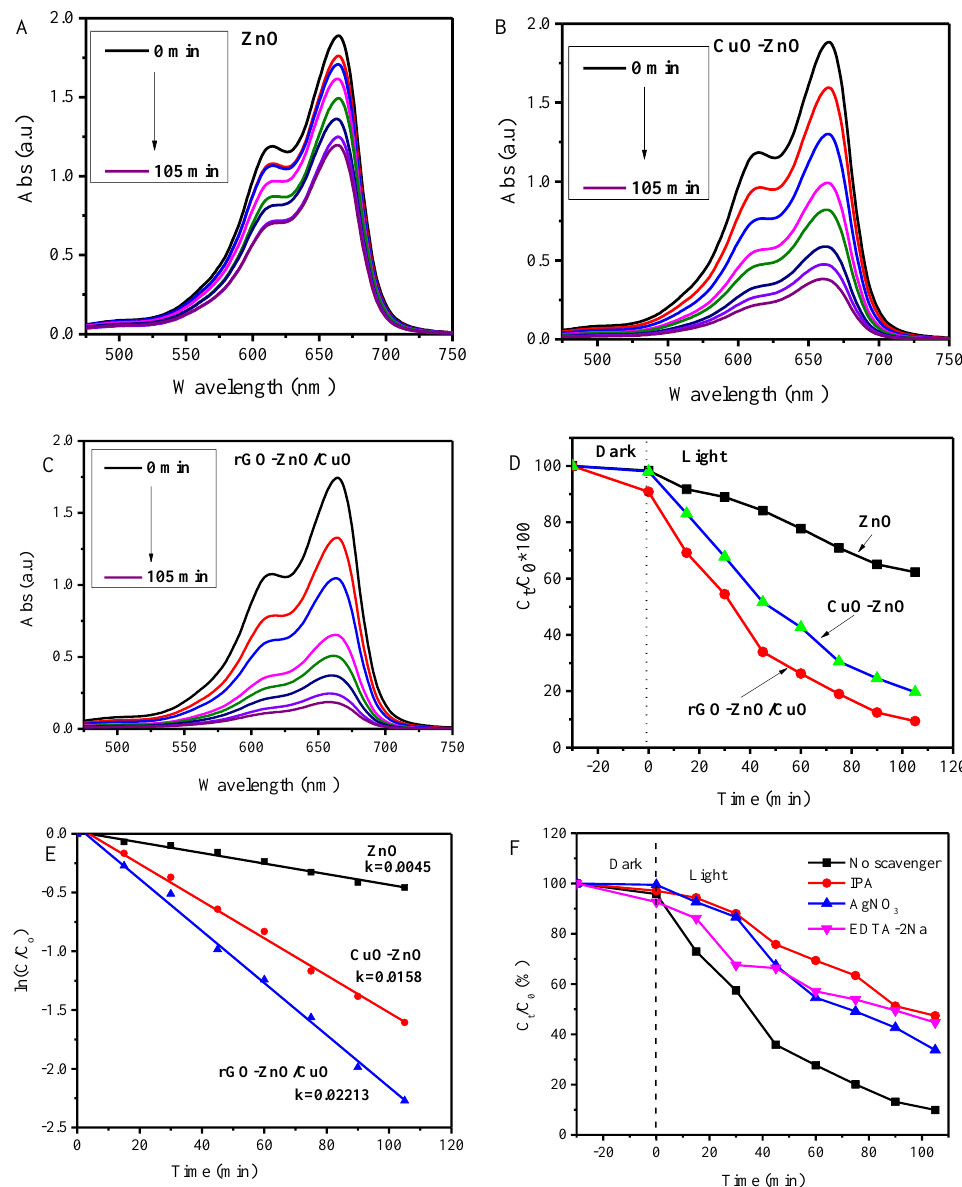
Figure 5. Progress of MB degradation using catalysts: ZnO NRs ( A ), CuO-ZnO NCs ( B ), and (rGO- ZnO)/CuO NCs ( C ); ( D ) plots of C t /C 0 vs. t; ( E ) plots of ln(C t /C 0 ) vs. t for MB degradation using ZnO, CuO-ZnO, and (rGO-ZnO)/CuO NCs; ( F ) effect of scavengers on the photocatalytic degradation of MB using (rGO-ZnO)/CuO NCs. Table 1. Comparison of (rGO-ZnO)/CuO NCs to previous reports against photocatalytic degrada- tion of MB.